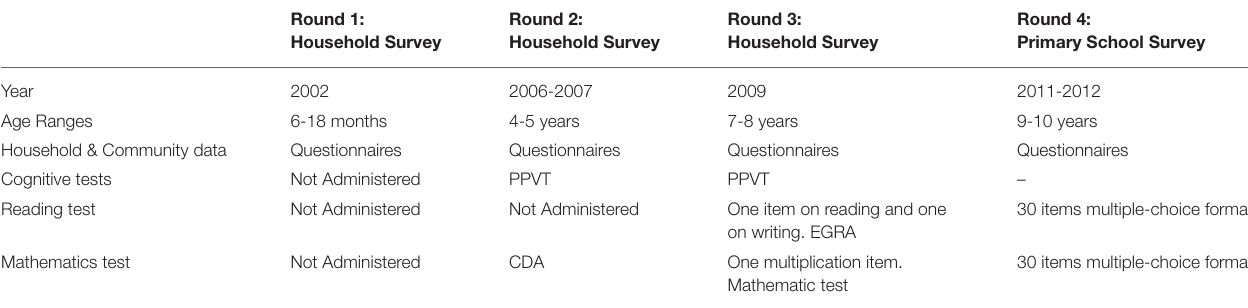
TABLE 1 | Household, cognitive and achievement measures administered in Young Lives.